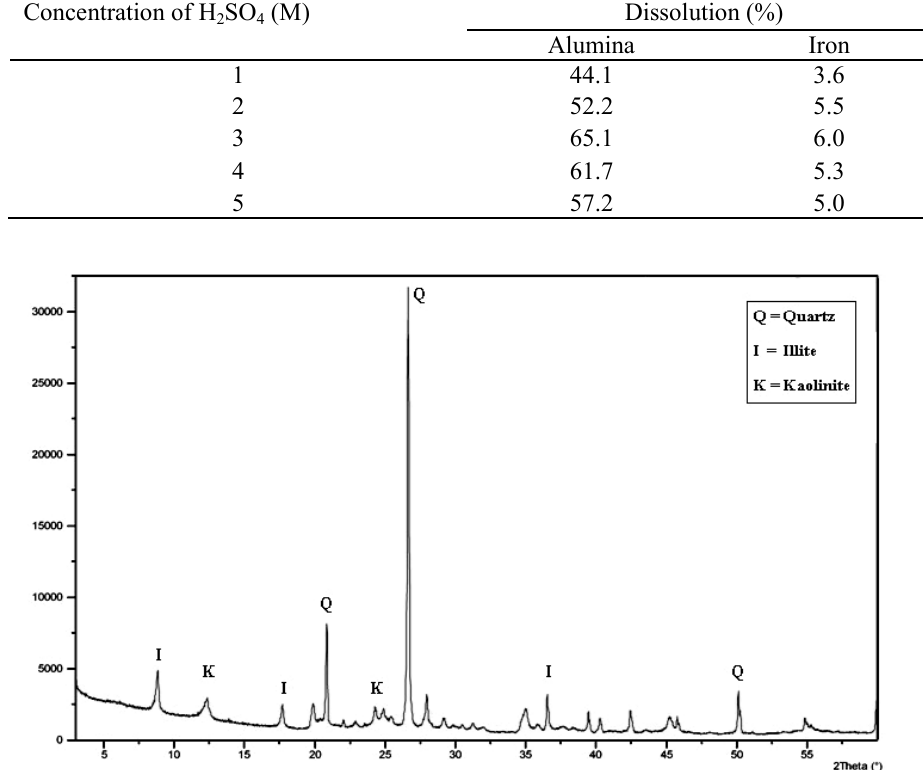
Figure 2. XRD pattern of Lampang clay.